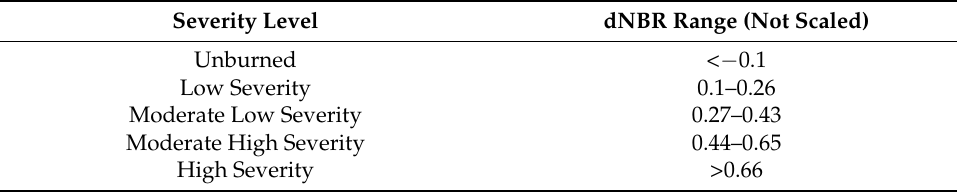
Table 3. Burn severity levels obtained by calculating dNBR, proposed by